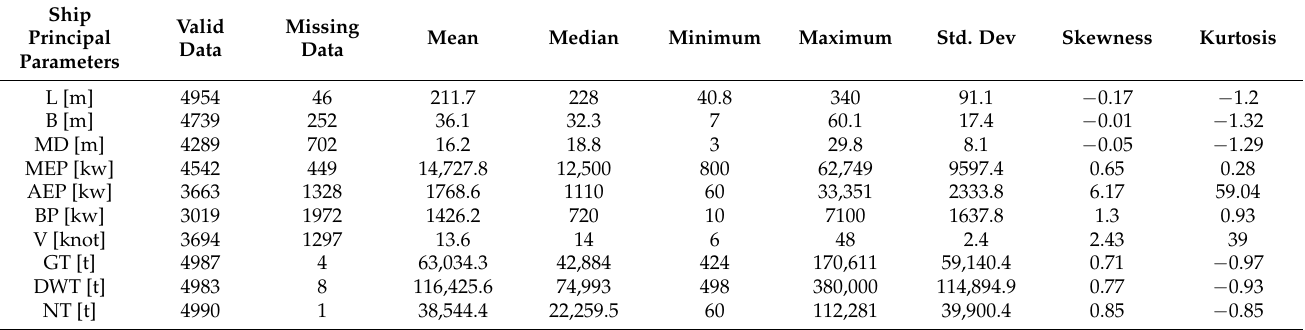
Table A2. Descriptive statistics of the main design parameters of 4991 tankers in ship static data.